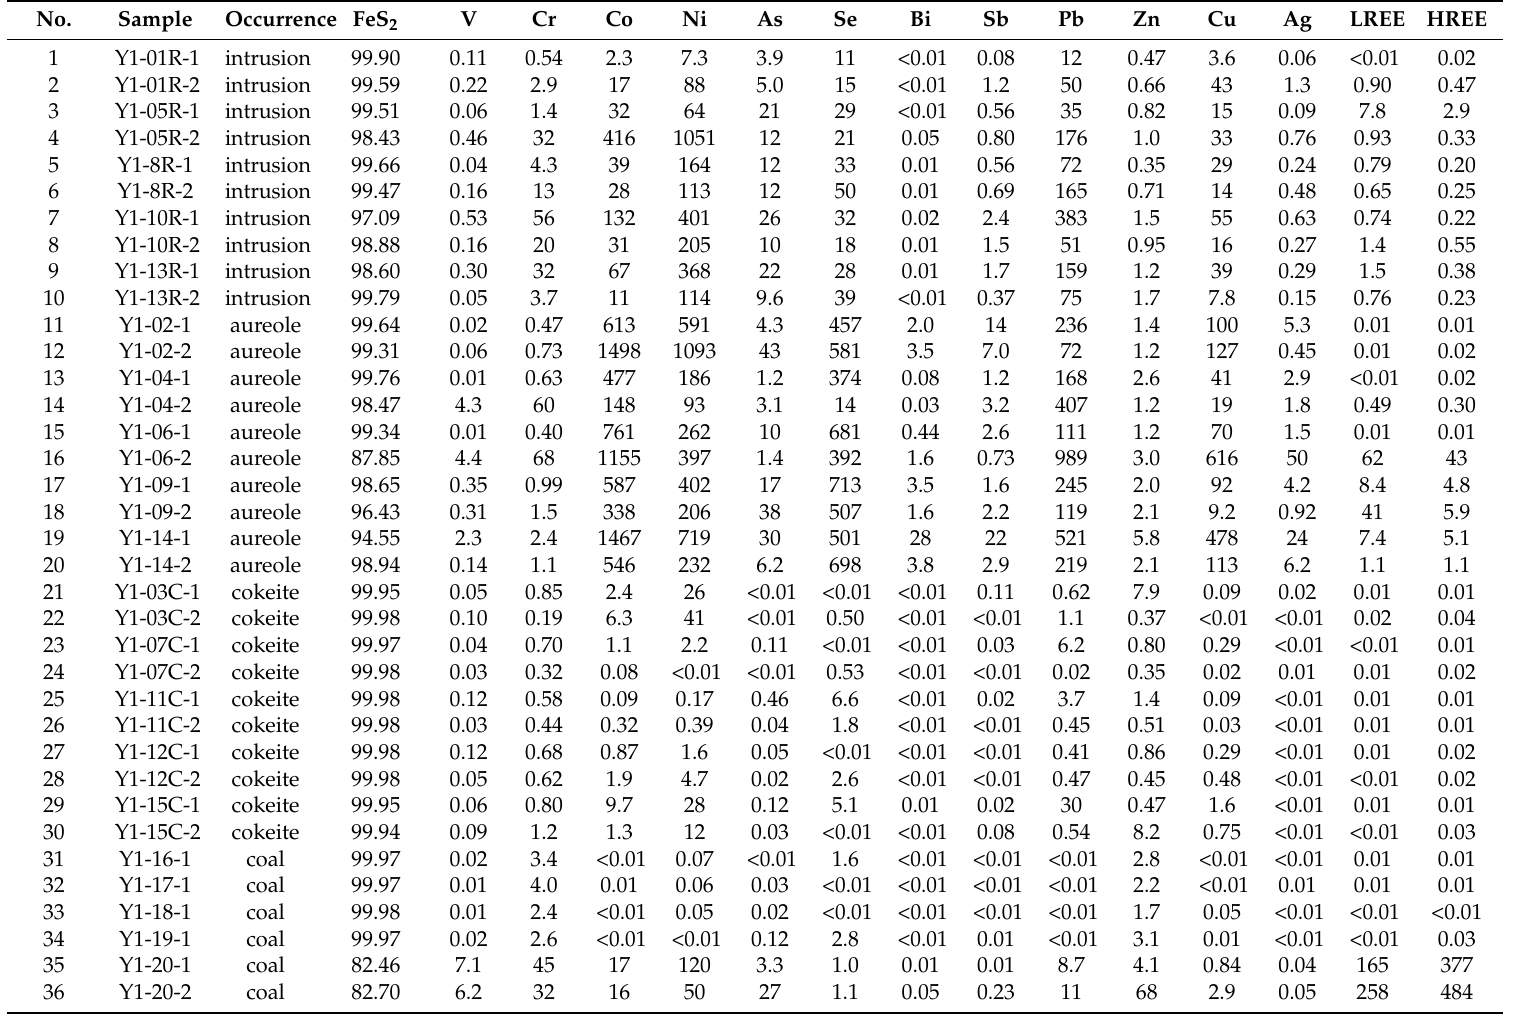
Table 2. LA-ICP-MS geochemical results (ppm) of the pyrites from the Yuandian Coal